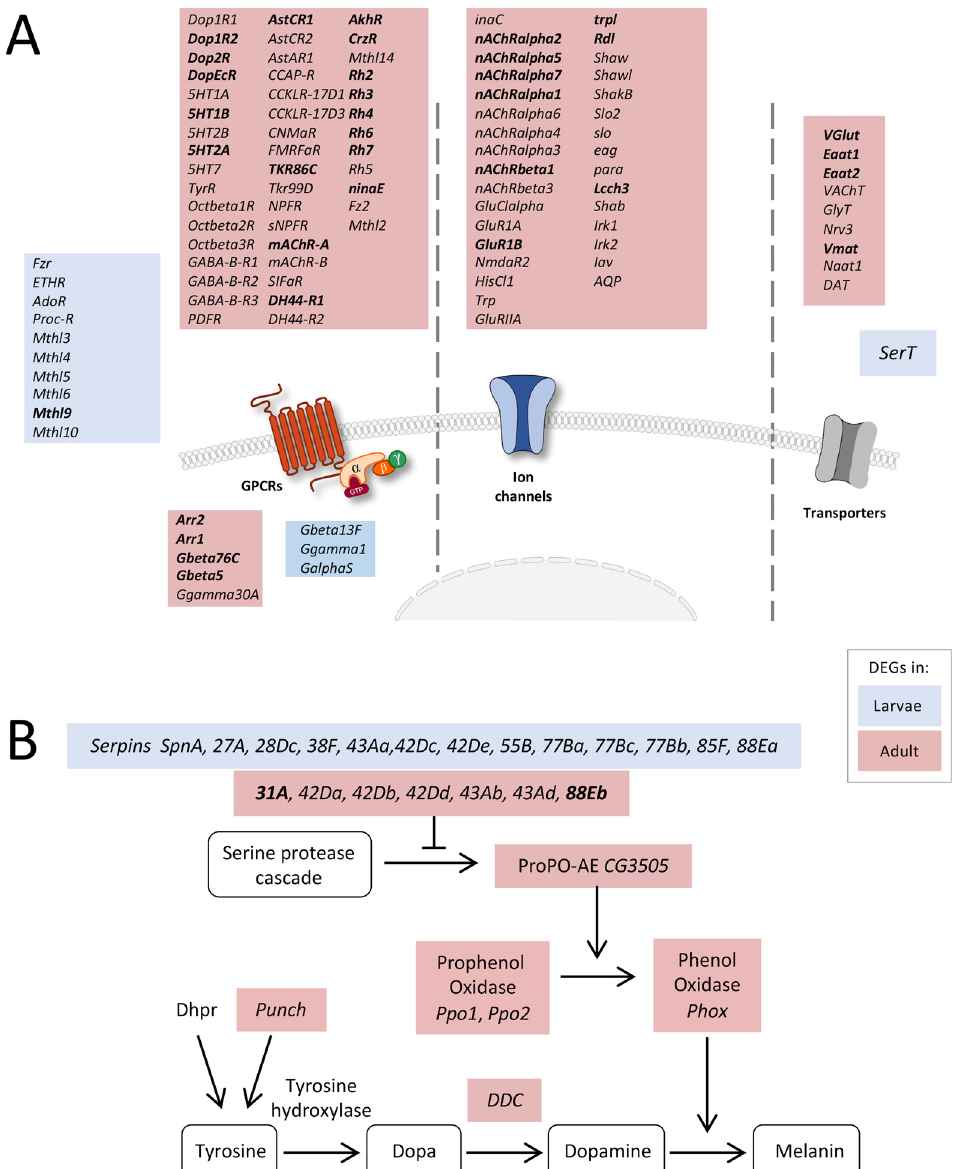
Figure 4. Expression of receptor-, transporter-, and transmembrane channel-coding genes. ( A ) Schematic overview of differentially expressed genes coding for proteins involved in signal transduction in adult and larval trachea. Receptors, channels, and transporters labeled in red represent the upregulation of the corresponding DEGs in adult tracheal cells, whereas blue-labeled ones represent upregulation in the larval system. ( B ) Scheme of components involved in the melanization process of larval and adult tracheal cells. Shown are all components of the melanization response in Drosophila and genes coding for corresponding components that were significantly upregulated either in larval (blue) or adult (red) trachea. Based on DEG with an FDR cutoff value of p < 0.05. DEG with a fold change >100 are emphasized in bold.